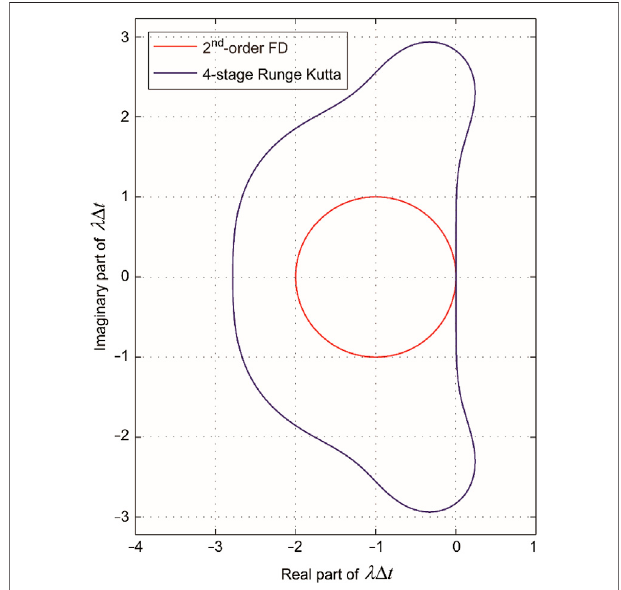
FIGURE 13 | Stability regions for different temporal discretization methods. The stability regions for the 2nd-order FD scheme and the 4-stage Runge Kutta scheme are the regions inside the red curve and the blue curve, respectively; while the instability regions for the 2nd-order FD scheme and the 4-stage Runge Kutta scheme are the regions outside the red curve and the blue curve, respectively. λ represents the eigenvalue of the discrete wave